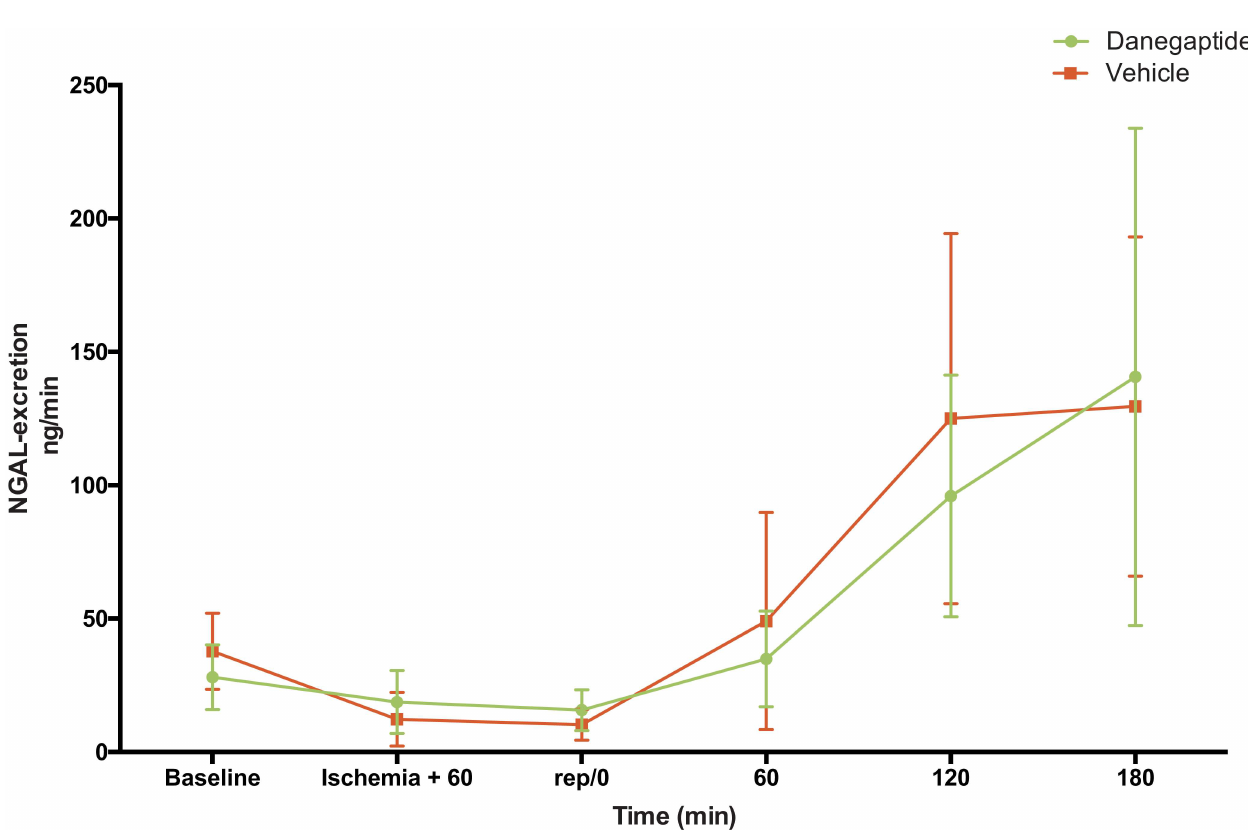
Fig 3. NGAL-excretion day 1- NGAL excretion rate in urine. Error bars represents95% CI.